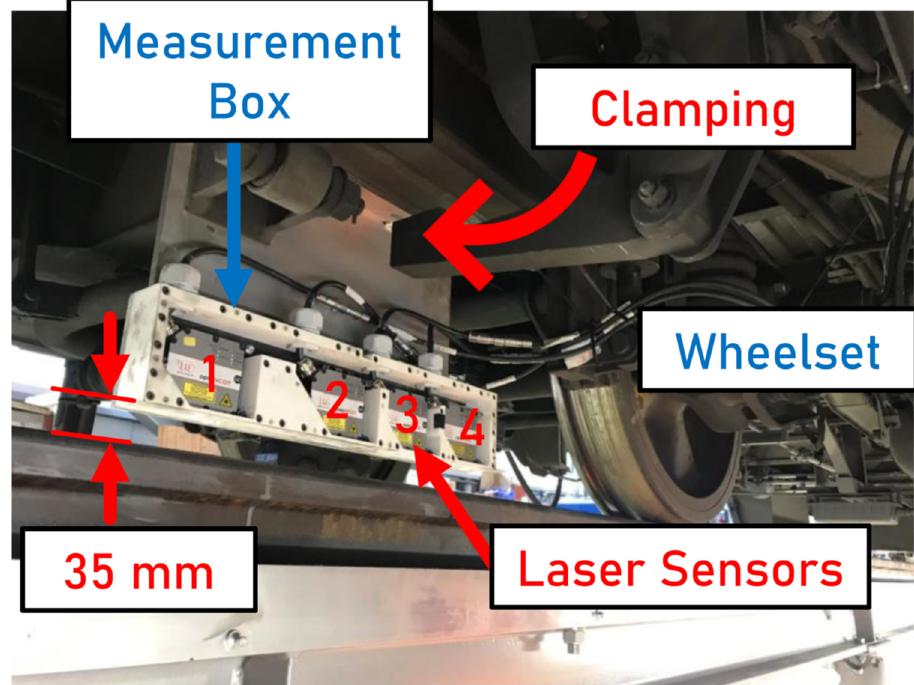
Figure 1. Experimental setup on the train with a measurement box, including four laser triangulation sensors (numbered 1 to 4) for distance measurements.